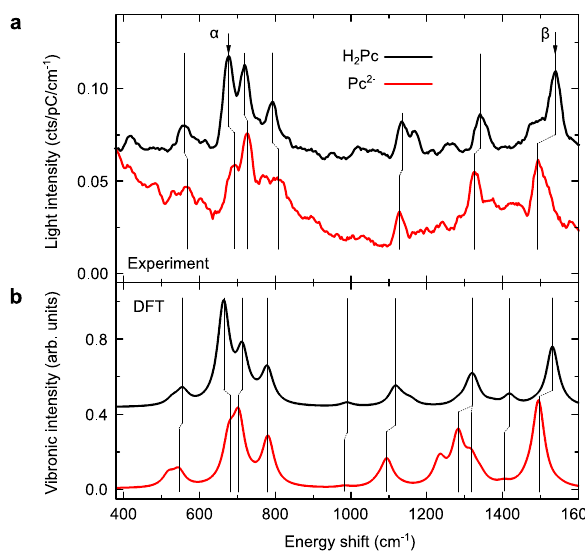
Fig. 4 Effect of the deprotonation on the vibronic signature of the phtahlocyanine molecule. a STML vibronic spectra ( I = 100 pA, acquisition time t = 120 s) of H 2 Pc ( V = − 2.5 V) and Pc 2 − ( V = 2.5 V) molecules on 3ML of NaCl compared with ( b ) theoretical vibronic intensities calculated for the molecules in vacuum. The Q x -line of H 2 Pc and Q-line of Pc 2 − are used as the origin of the experimental energy scale. α and β indicate vibronic modes for which the four nitrogen atoms of the pyrrole cycles stand nearly still. Source data are provided as a Source Data fi